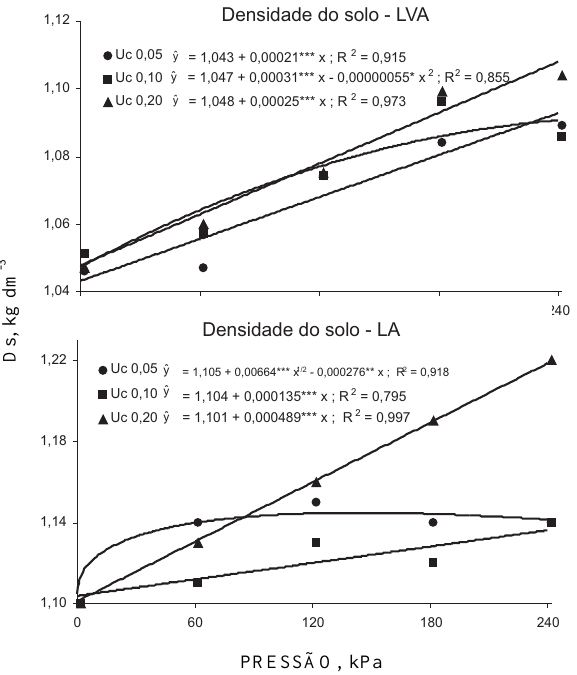
PRESSÃO, Figura 1. Densidade de dois Latossolos compactados com diferentes pressões e umidades.